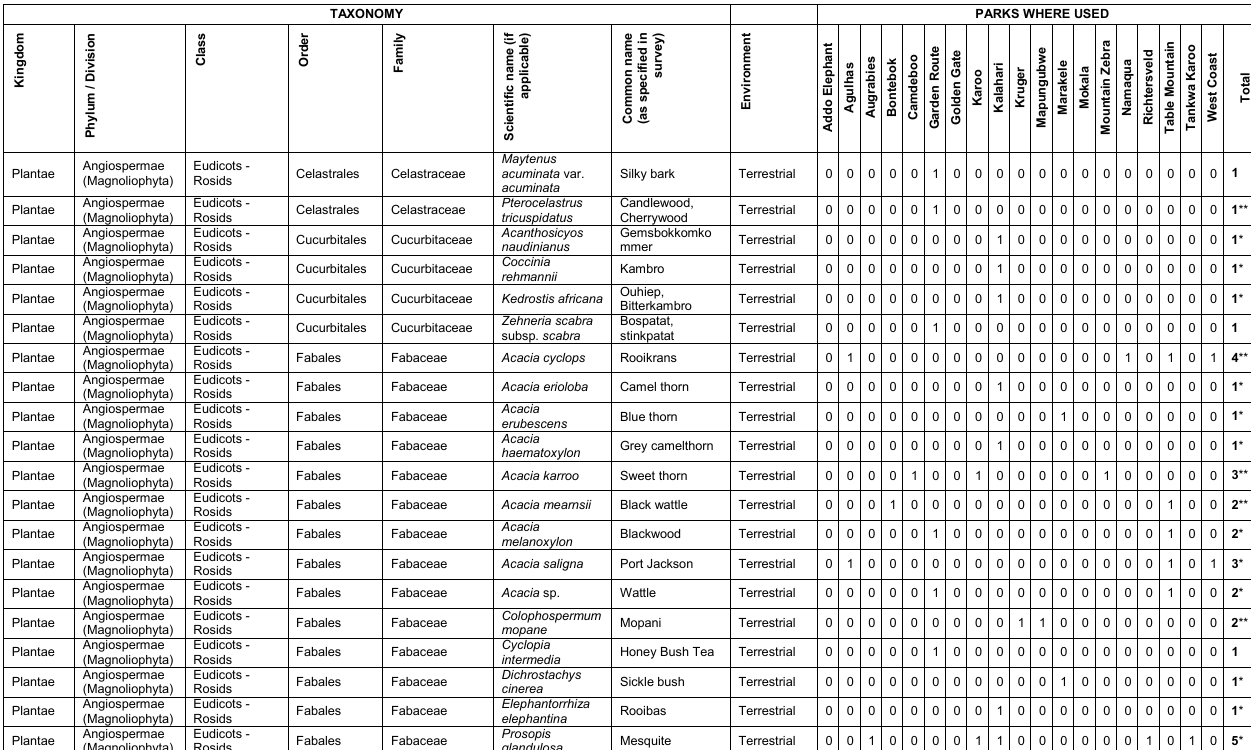
TAXONOMY PARKS WHERE USED